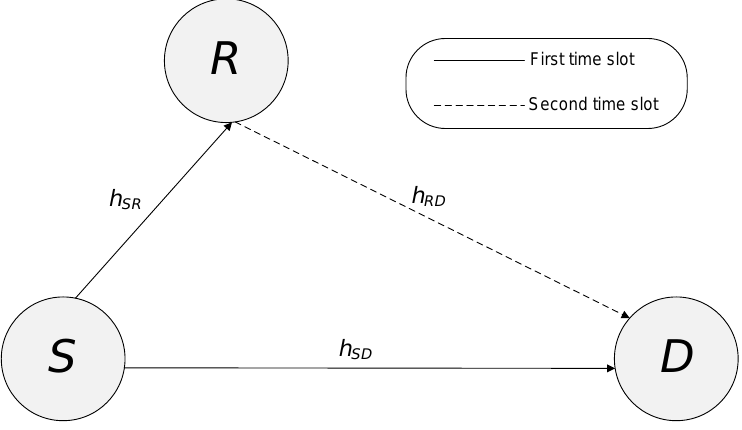
Figure 1. Relaying system including source S , relay R , and destination D